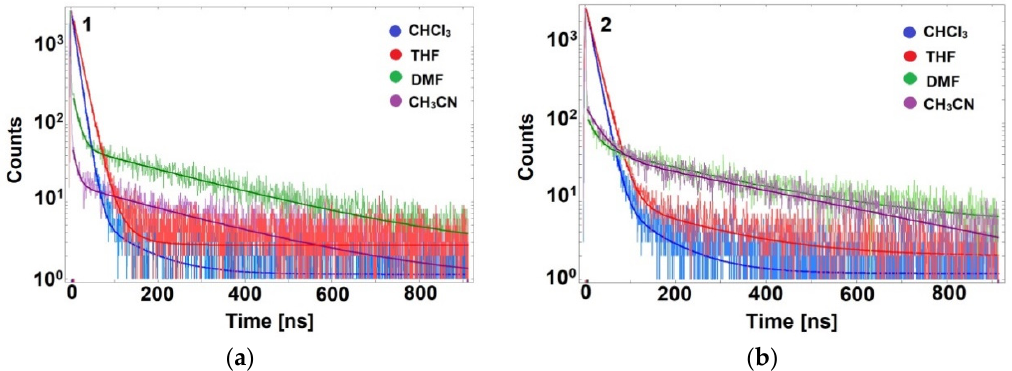
Figure 6. TCSPC decay curves for compounds 1 ( a ) and 2 ( b ) in different solvents.